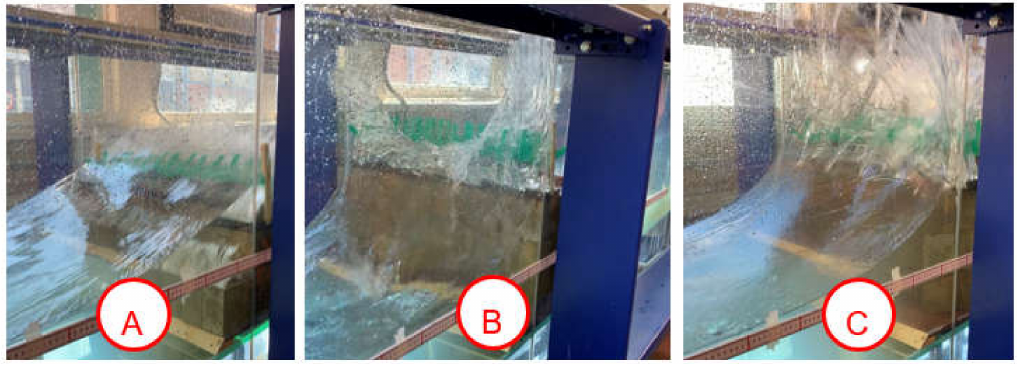
Figure 15. Resultant wave shapes for Configurations